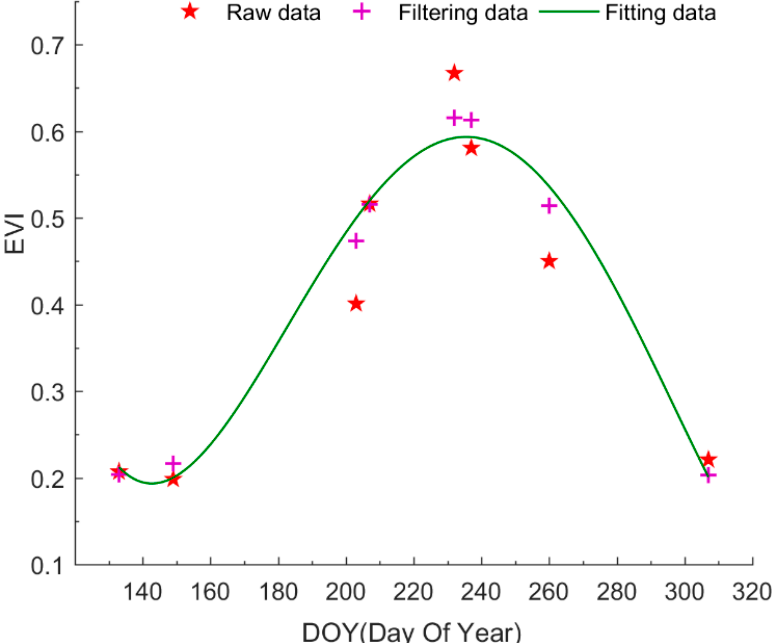
Figure 3. Enhanced vegetation index (EVI) time series curve of rice.